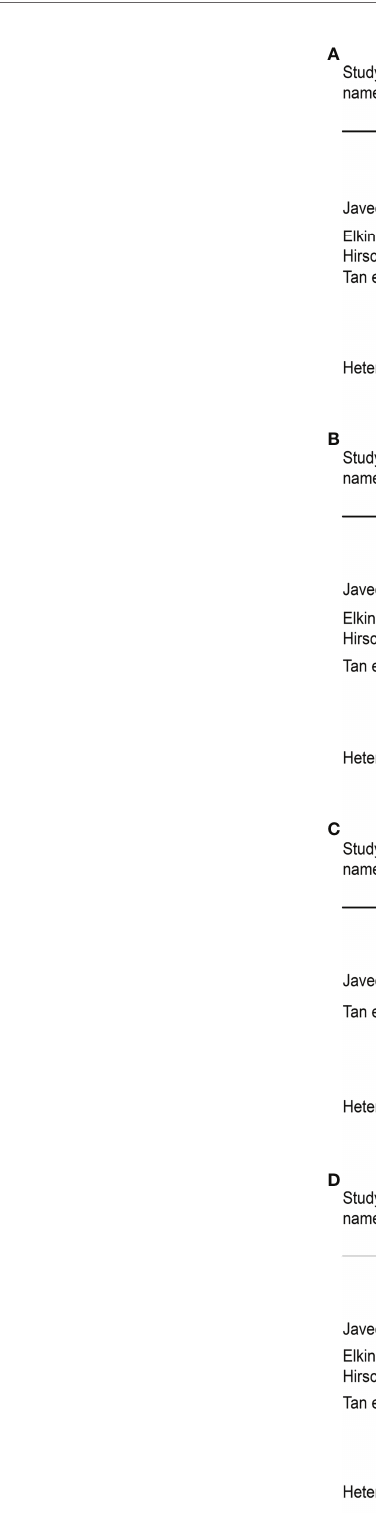
FIGURE 3 | Effect of SGLT-2is versus control on (A) FAI, (B) total testosterone (TT), (C) sex-hormone binding globulin (SHBG), and (D) dehydroepiandrosterone sulphate (DHEAS). *Std: